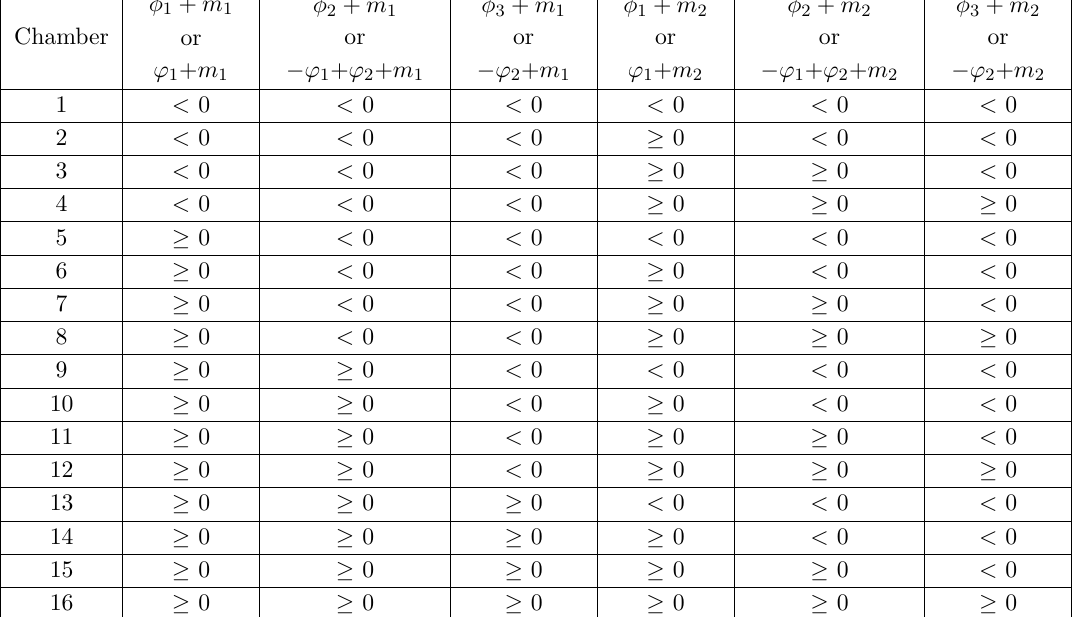
Table 6 . Chamber de(cid:12)nitions of the U(3) k variables ( (cid:30) 1 ; (cid:30) 2 ; (cid:30) 3 ) denote U(3) vevs, while the variables ( ’ 1 ; ’ 2 ) denote SU(3) vevs. 2 Coulomb vevs ( ’ 1 ; ’ 2 ), one gauge coupling h 0 and two real masses m 1 ; m 2